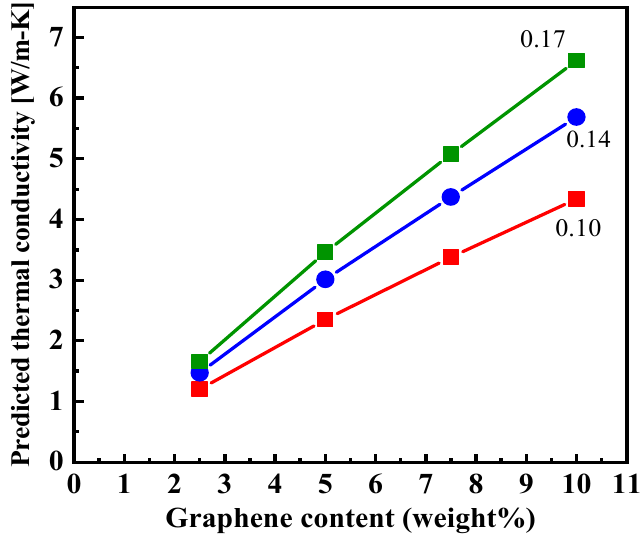
Figure 6. Predicted thermal conductivity value based on the effective medium theory (EMT) with different graphene–graphene interlayer thermal conductivity.